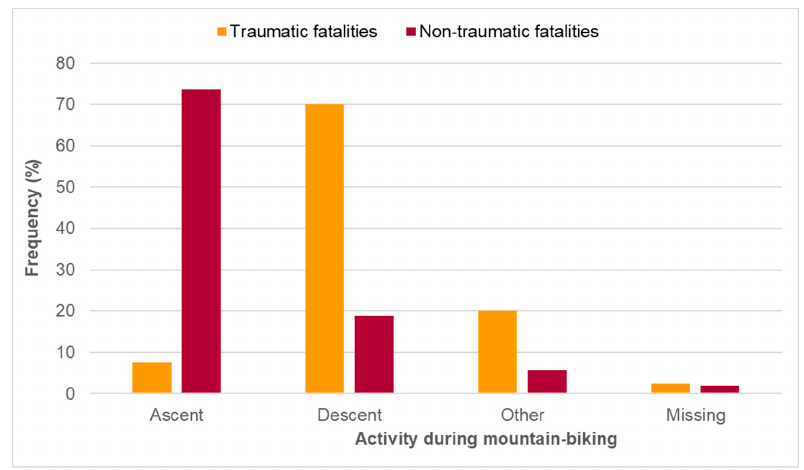
Figure 2. Overall cause of mortality during recreational MTB in the Austrian Alps in the period 2006–2021 divided by activity, i.e., ascent vs. descent (n = 93). Orange columns = traumatic fatalities (n = 40), red columns = non-traumatic fatalities (n = 53). Values are relative frequencies. Significance level: p < 0.001. Concerning traumatic fatalities, causes of accidents, injury locations, and injury types are presented in Table 2. They were usually caused by falls on the way (40.0%) and often affected the whole body (40.0%), in which case they were classified as polytrauma. Table 2. Causes of accident, injury locations, and injury types associated with traumatic fatal deaths of recreational mountain-bikers (n = 40) in Austria during the period 2006–2021. Data are presented as absolute and relative frequencies.